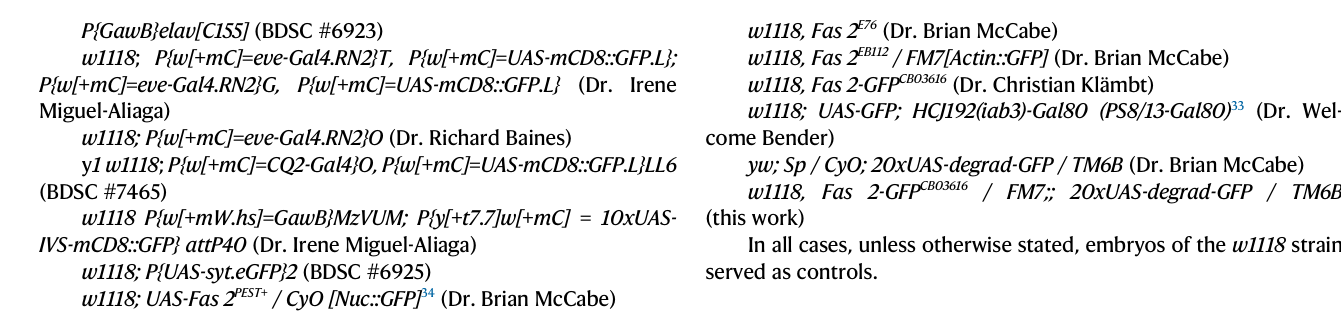
Fig. 7 | JNK signaling activity in pioneer neurons modulates the architectural organization of the CNS. a Regulatory network modulating VNC architectural organization and condensation. Precise JNK activity levels in early-speci fi ed neu- rons(aCC,pCC,RP2andVUMs)areregulatedbyaprimarynegative feedbackloop mediated by Puc. Excessive JNK activity in puc mutants or upon early over- expression of Hep CA (constitutively active JNKK) in aCC, pCC, RP2 and/or